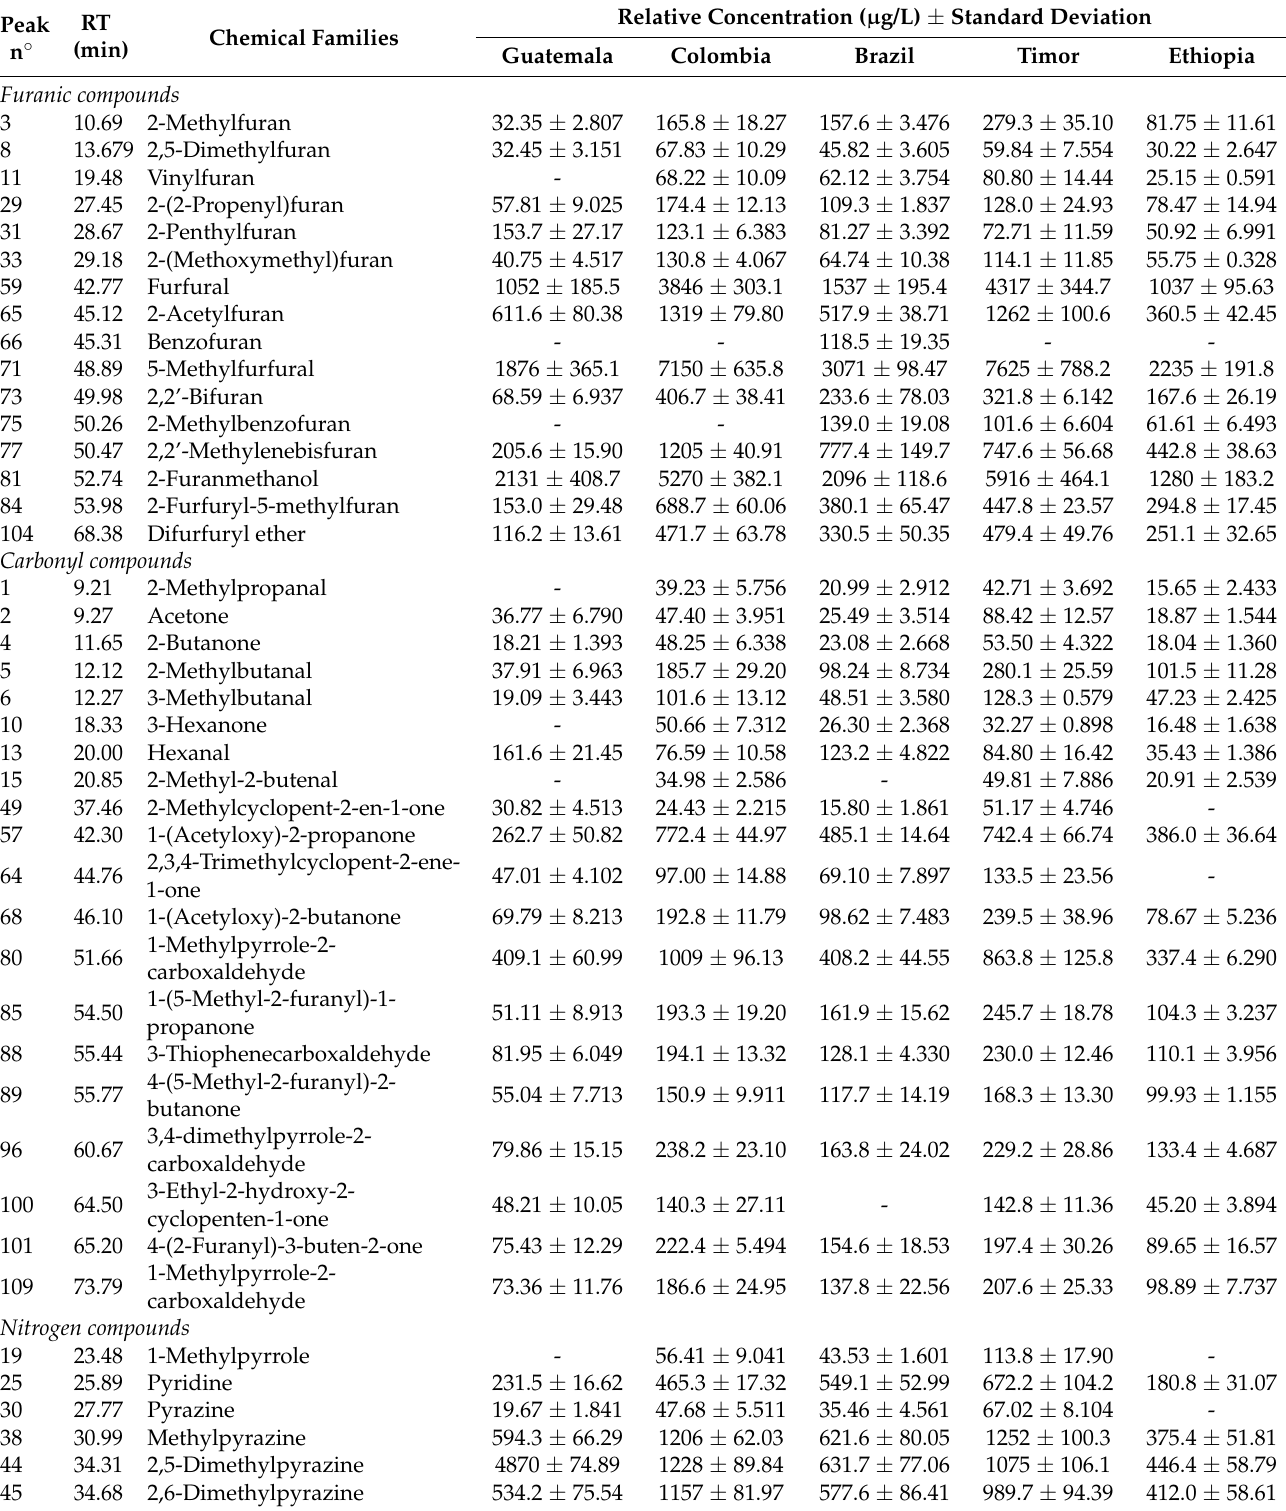
Table 1. Relative concentration ( µ g/L) of volatile organic compounds in the spent coffee grounds from different geographical origins using